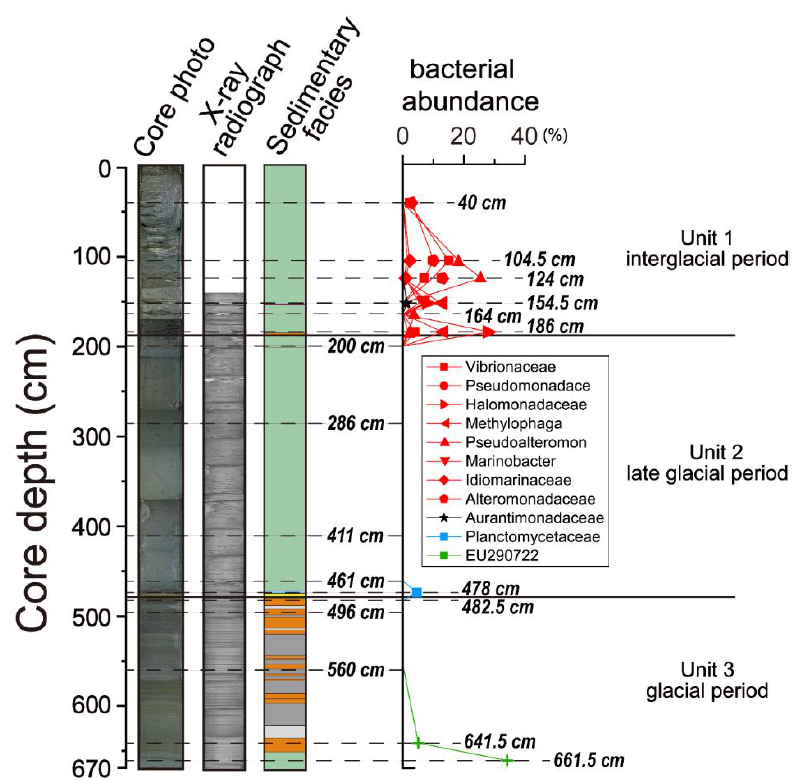
Figure 9. Bacterial Abundance Coupled with Sedimentary Facies from Core DPC1801. Dotted lines indicate the sampling location with depths. The red figures represent Gammaproteobacteria , while the black figures represent Alphaproteobacteria . The blue figures represent ANAMMOX bacteria, and the green figures represent EU290722 .